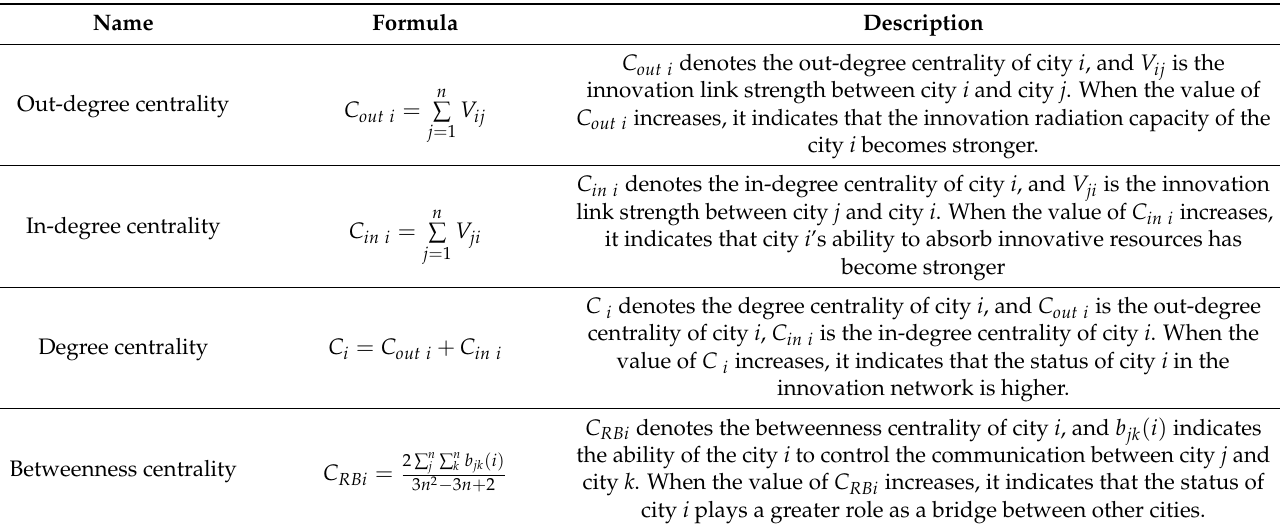
Table 2. Calculation formulae of centrality